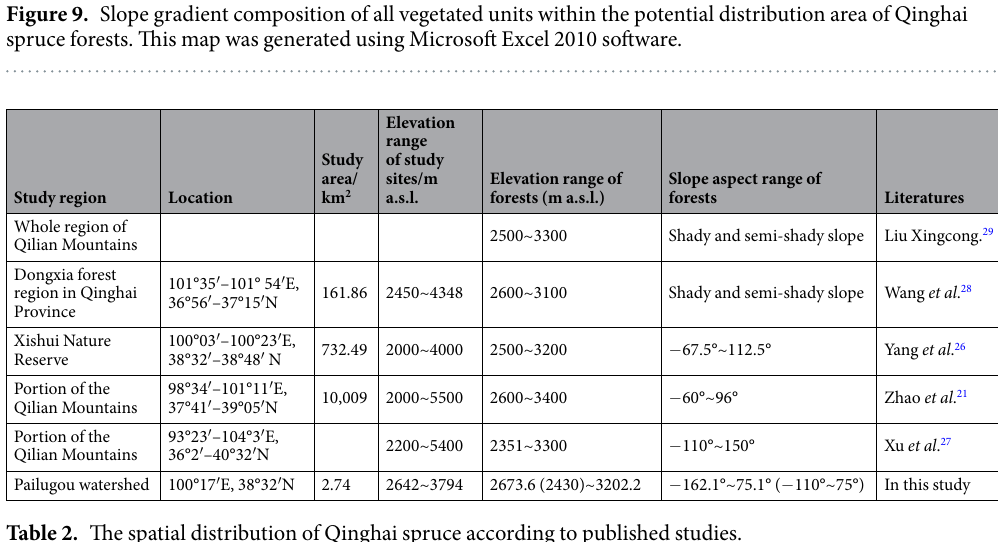
Table 2. The spatial distribution of Qinghai spruce according to published